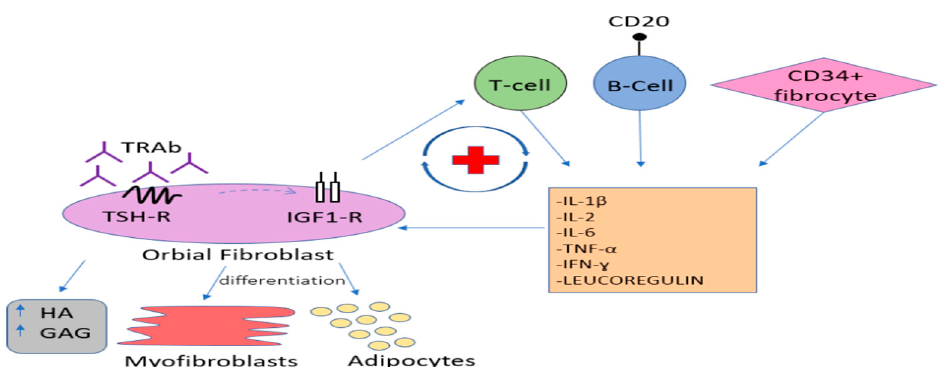
Figure 1. Signaling cascade involved in Graves’ orbitopathy (GO) pathogenesis. IGF1-R: insulin-like growth factor 1 receptor, TSH-R: thyrotropin receptor, TRAb: Thyrotropin receptor antibodies, HA: Hyaluronic Acid, GAG: glycosaminoglycans, IL-1 β : interleukin-1 β , IL-2: interleukin-2, IL-6: interleukin-6, TNF- α : tumour necrosis factor alpha, IFN-y: interferon gamma.